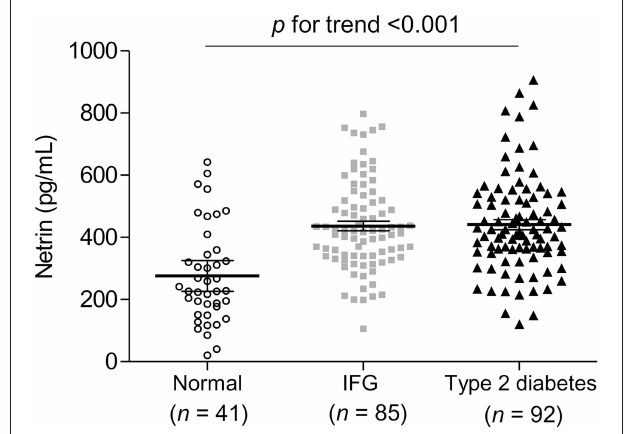
FIGURE 1 | Comparison of serum netrin concentrations according to glycemic status. Each horizontal line indicates the mean with 95% confidence interval. IFG, impaired fasting glucose.